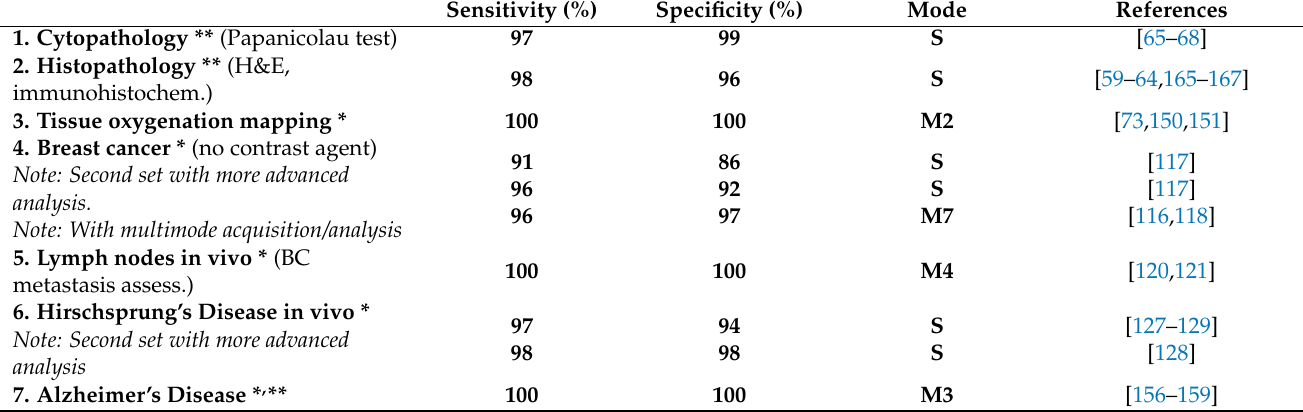
Table 2. Advanced imaging for specificity & sensitivity in our pre-clinical * and clinical **